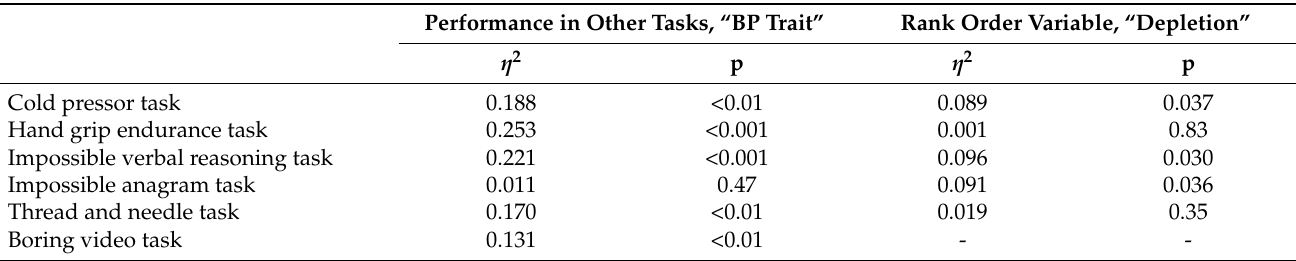
Table 5. Relative effect sizes for separate variables. One analysis is presented per row, “BP trait” and “depletion” variables were used to explain the performances in the tasks in the left